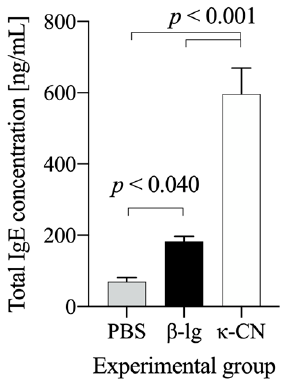
Figure 4. Total serum IgE concentration in mice immunized with β -lg (black bar) and κ -CN (white bar). The data are expressed as means ± SD. Statistical analysis was performed with one-way ANOVA follow by Tukey’s post hoc